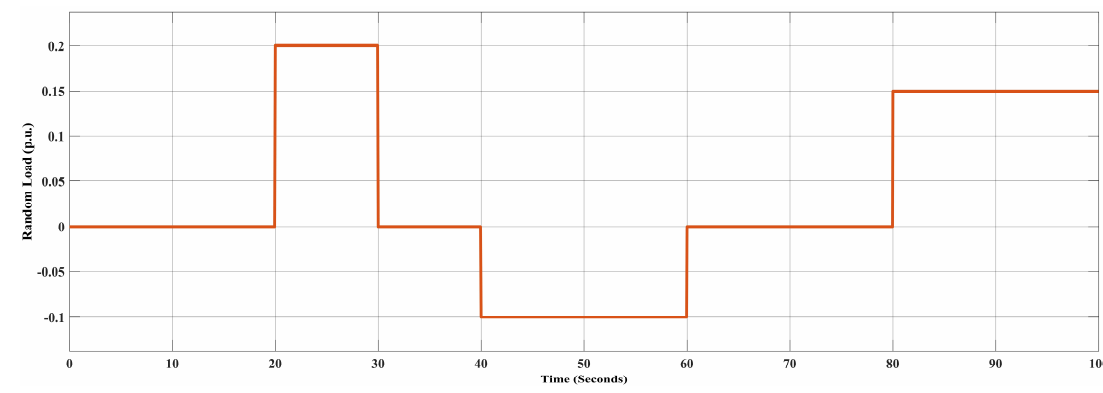
Figure 8. Random load profile.